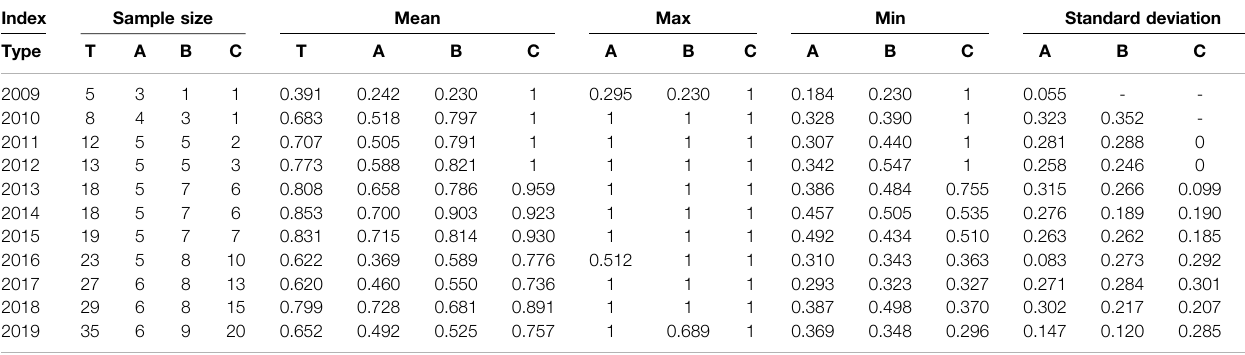
TABLE 6 | Descriptive Statistics of crs green credit ef fi ciency from 2009 to 2019.